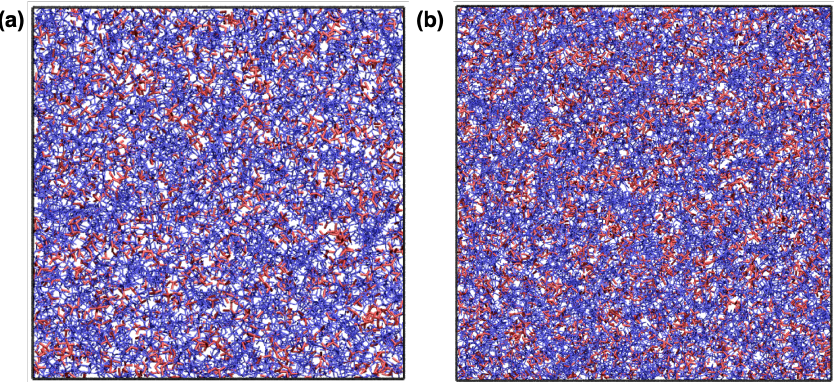
Figure 5. Representative snapshots for ( a ) p-CEIL-2 and ( b ) p-CEIL-3. Colour code: red and blue for Tf 2 N − and CEIL-2 (in ( a )) or CEIL-3 (in ( b )), respectively. Solid black lines represent simulation cell boundaries.